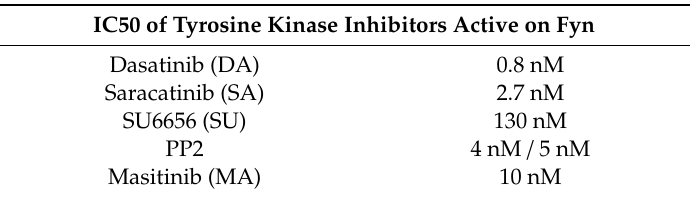
Table 2. Tyrosine kinase inhibitors. Commercial name of TKIs and their abbreviations are reported on the left. Fyn TK IC50 is listed on the